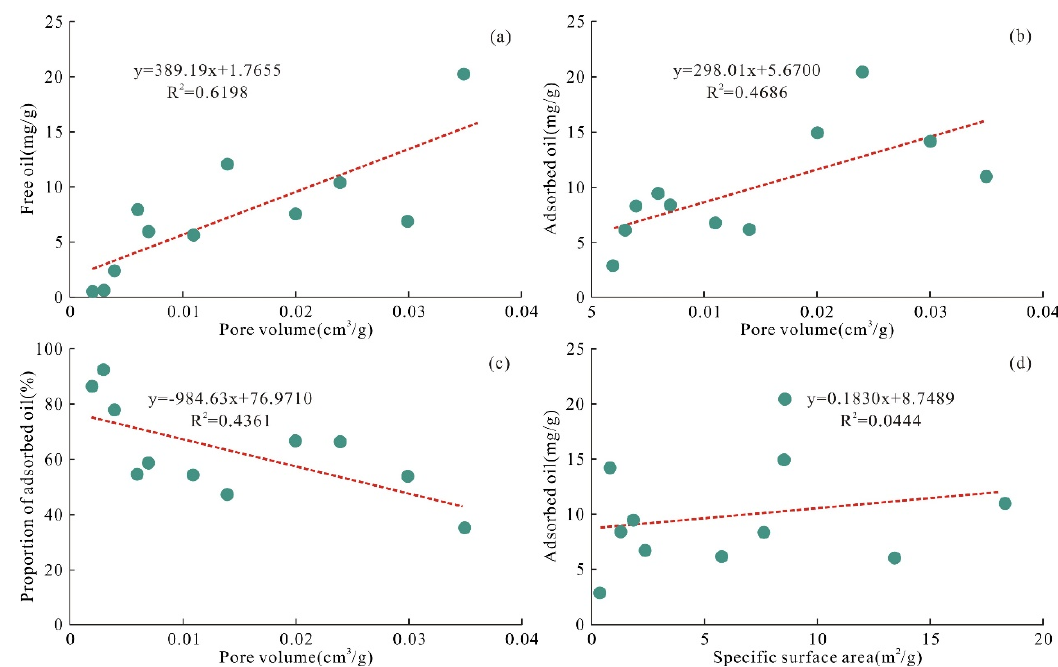
Figure 15. Correlations ( a ) between free oil and pore volume, ( b ) between adsorbed oil and pore volume, ( c ) between the proportion of adsorbed oil and pore volume, and ( d ) between adsorbed oil and specific surface area of the Ek 2 shale in the Cangdong Sag.